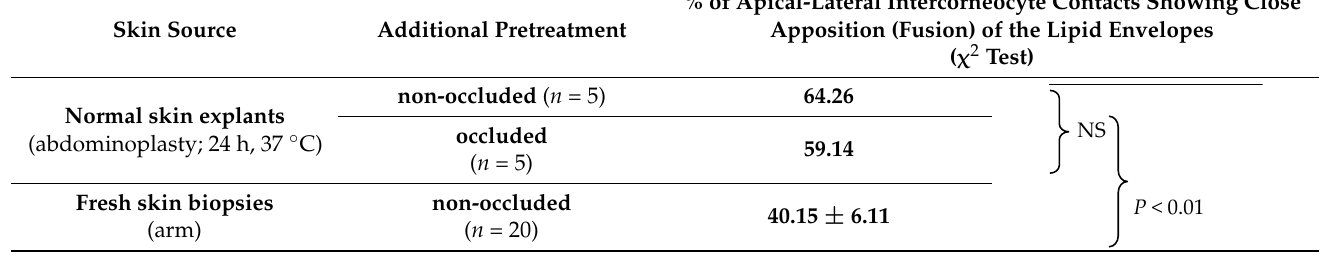
Table 1. TJ-like points of fusion in the lowermost SC (SC compactum) of normal human skin. Table 1 . TJ-like points of fusion in the lowermost SC (SC compactum) of normal human